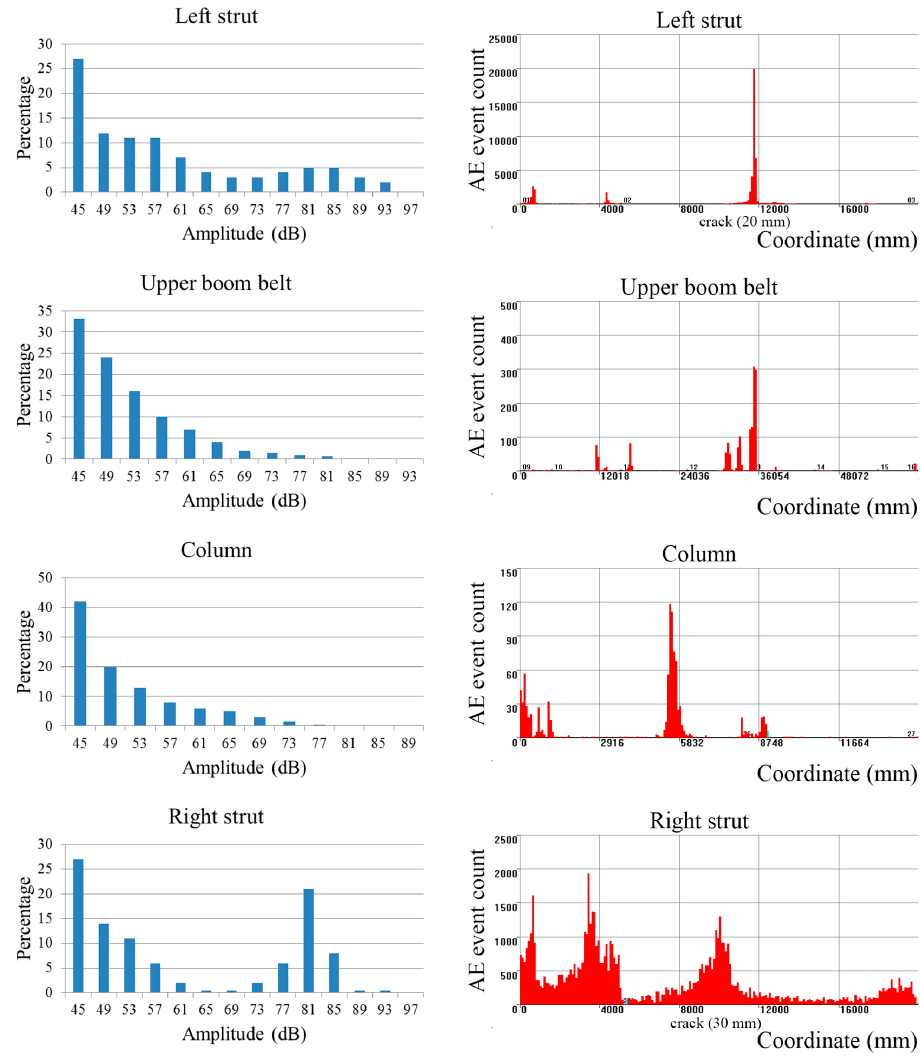
Figure 27. Results of acoustic emission location.